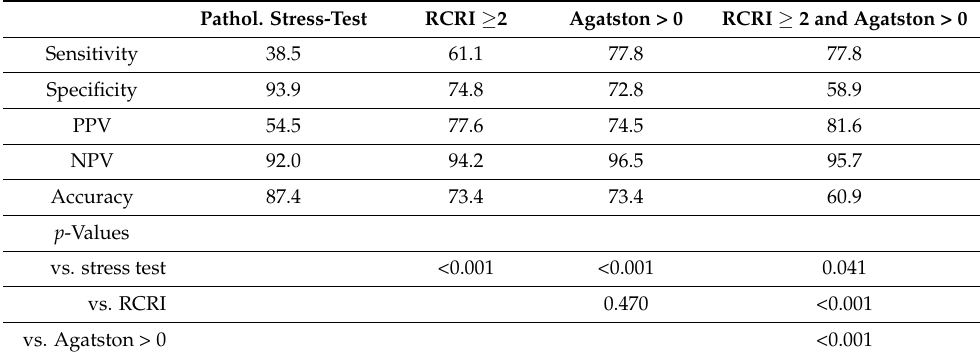
Table 2. Accuracy of the stress tests and Agatston score to detect obstructive coronary artery disease.